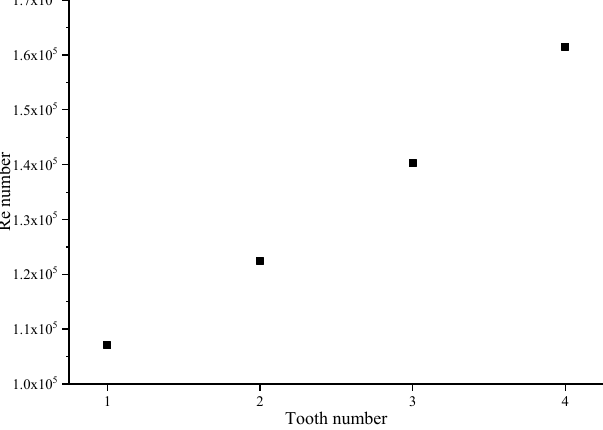
Figure 20. The local Re number at different teeth.